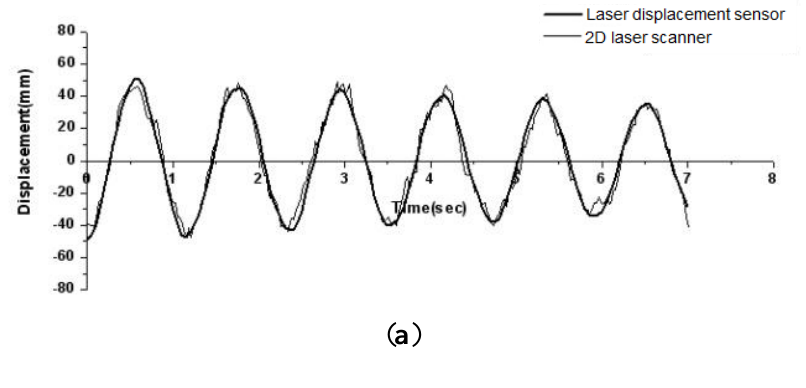
Figure 7. Comparison of the smoothed time history responses with directly